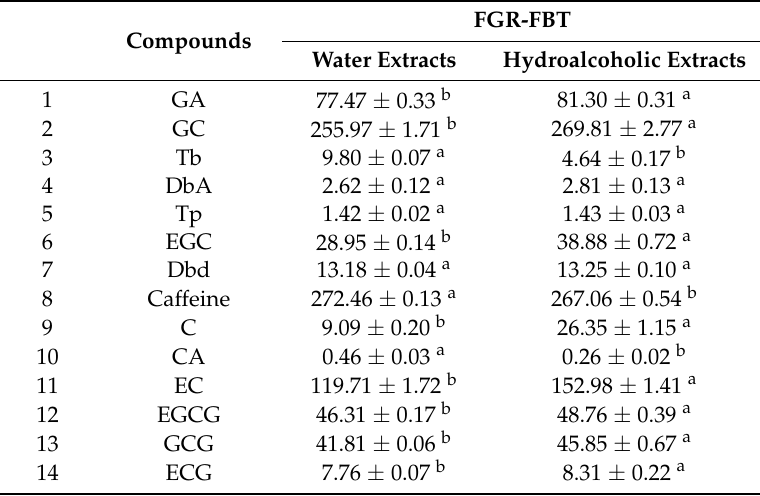
Table 2. Major functional compounds of water and hydroalcoholic extracts (80% ethanol extracts) of fermented glutinous rice with Fu brick tea